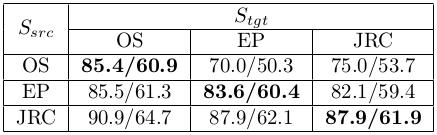
Table from the paper: Monolingual and Cross-lingual Zero-shot Style Transfer
Table text:
S src
S tgt
OS
EP
JRC
OS
85.4/60.9
70.0/50.3
75.0/53.7
EP
85.5/61.3
83.6/60.4
82.1/59.4
JRC
90.9/64.7
87.9/62.1
87.9/61.9